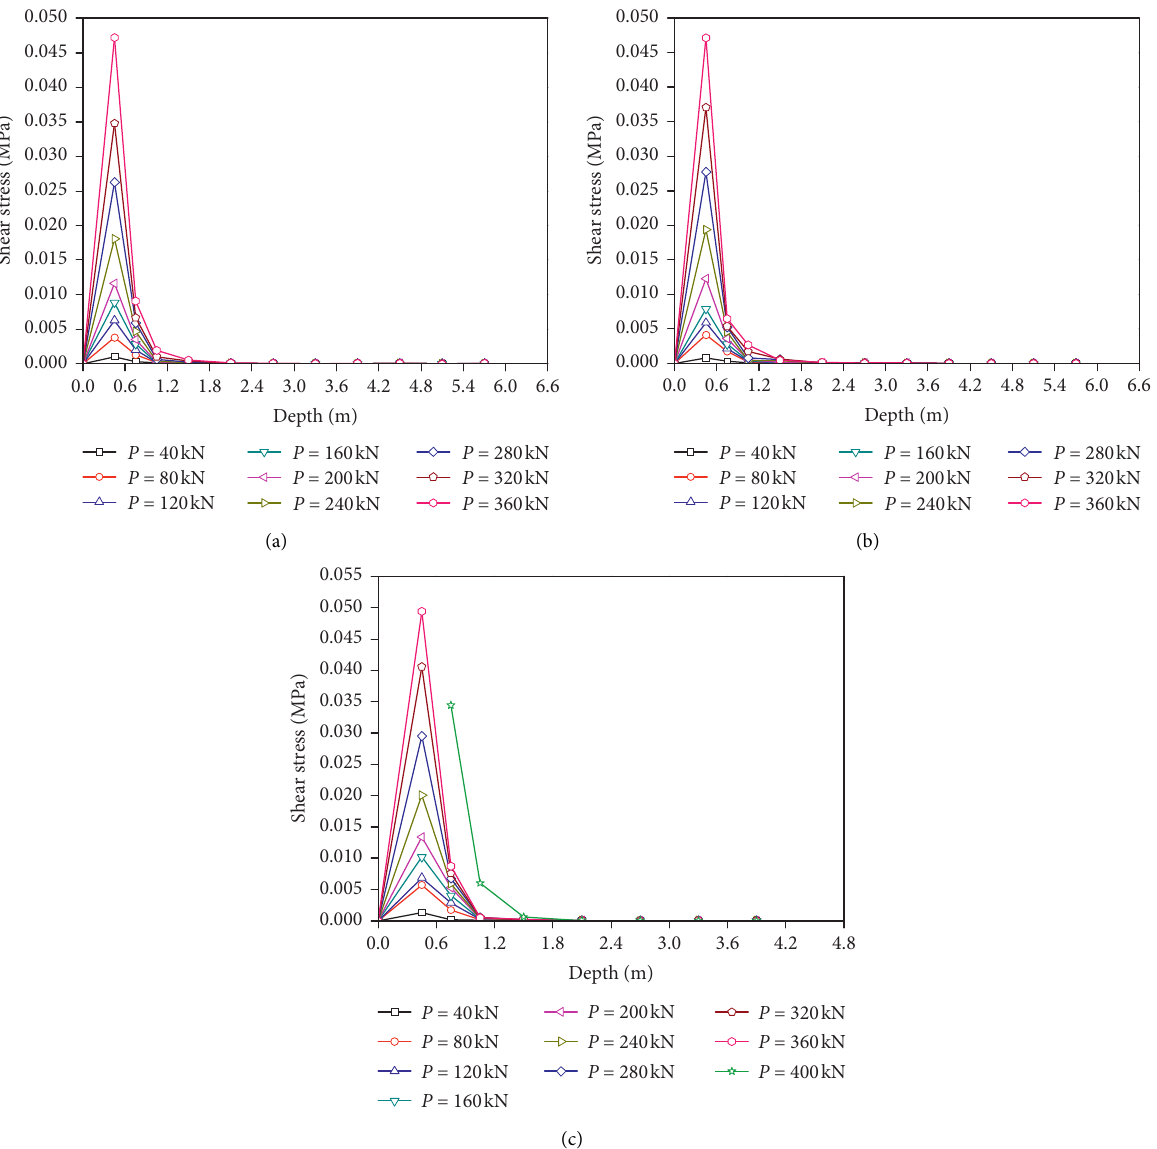
Figure 16: Shear stress of the second interface at different depths: (a) G-28-6.5-1, (b) G-28-6.5-2, and (c) G-28-4.5-1.